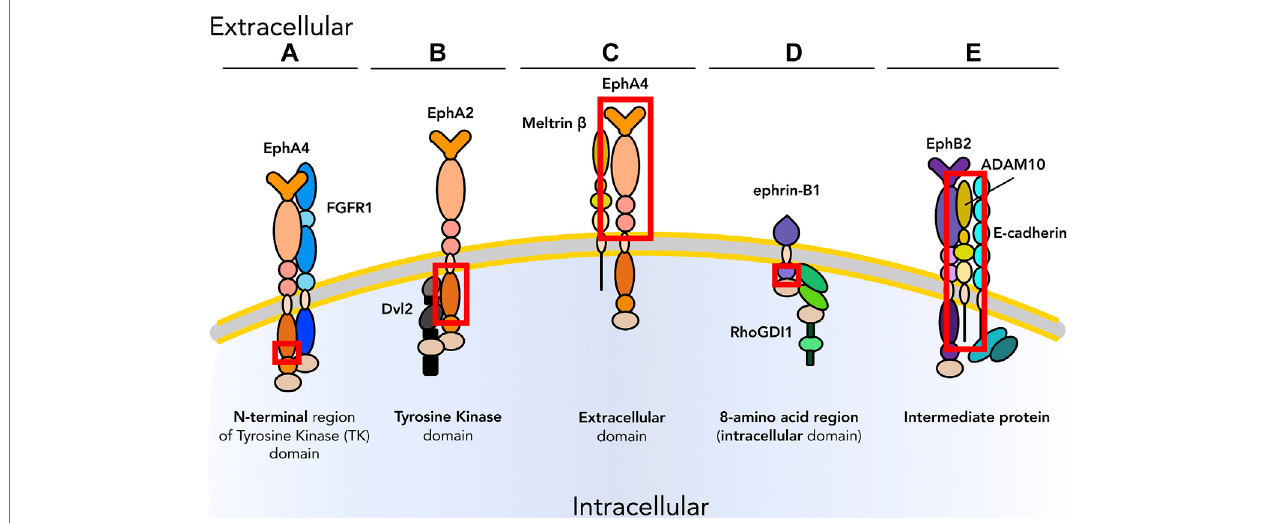
FIGURE 1 | Graphical representation of examples of experimentally demonstrated in cis binding modalities of Ephs and ephrins with other membrane proteins. In cis interactions can occur via (A) N-terminal region of the tyrosine kinase (TK) domain; (B) TK domain; (C) extracellular domain; (D) intracellular domain (8-amino acid region); (E) intermediate